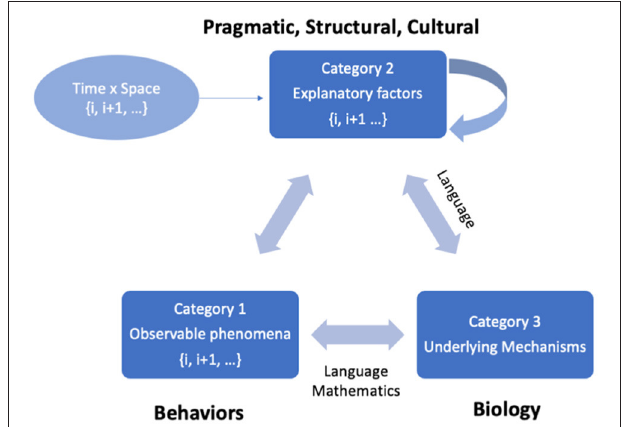
FIGURE 1 | Bateson’s cybernetic model of knowledge production. In neuropsychological research, the primary aim is to understand underlying mechanisms that give rise to an observable phenomenon. The relation between underlying mechanisms and the observable phenomena is mediated over time by various explanatory variables that may be interpreted flexibly within given contexts. Explanatory variables are influenced by various pragmatic, structural and cultural constraints and are prone to conflicts (including double binds) which involve recursive looping processes that must be studied over time and across contexts. The knowledge that emerges in this cybernetic model is often language dependent; however, if concepts are operationalized in measurable ways and sufficient data are collected, certain aspects can be represented by formal mathematical